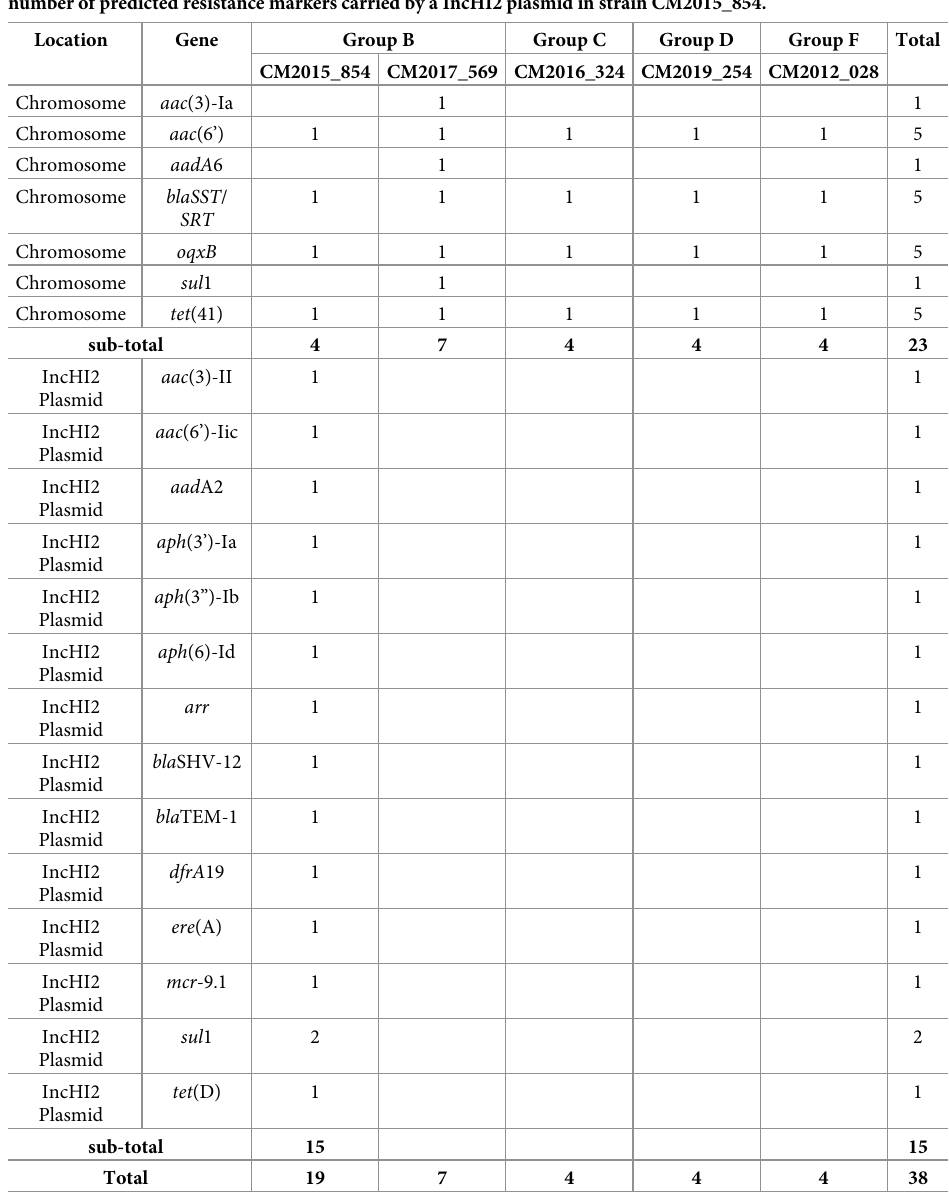
Table 5. Predicted ARGs in fully assembled genomes of representative Serratia spp. isolates, showing the high number of predicted resistance markers carried by a IncHI2 plasmid in strain